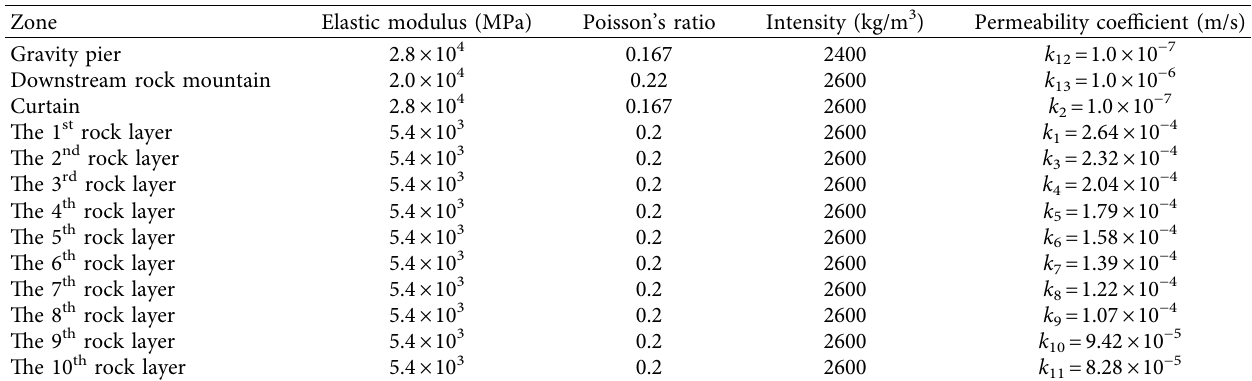
Figure 12: 2D model and the zoning results of the dam foundation. (a) 2D finite element model; (b) divisions of the F Table 1: Material mechanical and seepage parameters.